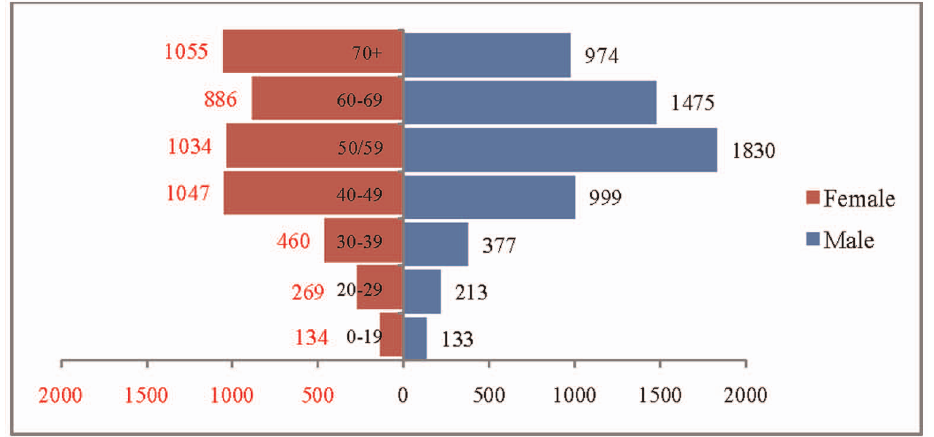
Figure 10. Estimated number of hospitalisation due to CVDs (in 000’s) by age and sex, India, 2021.